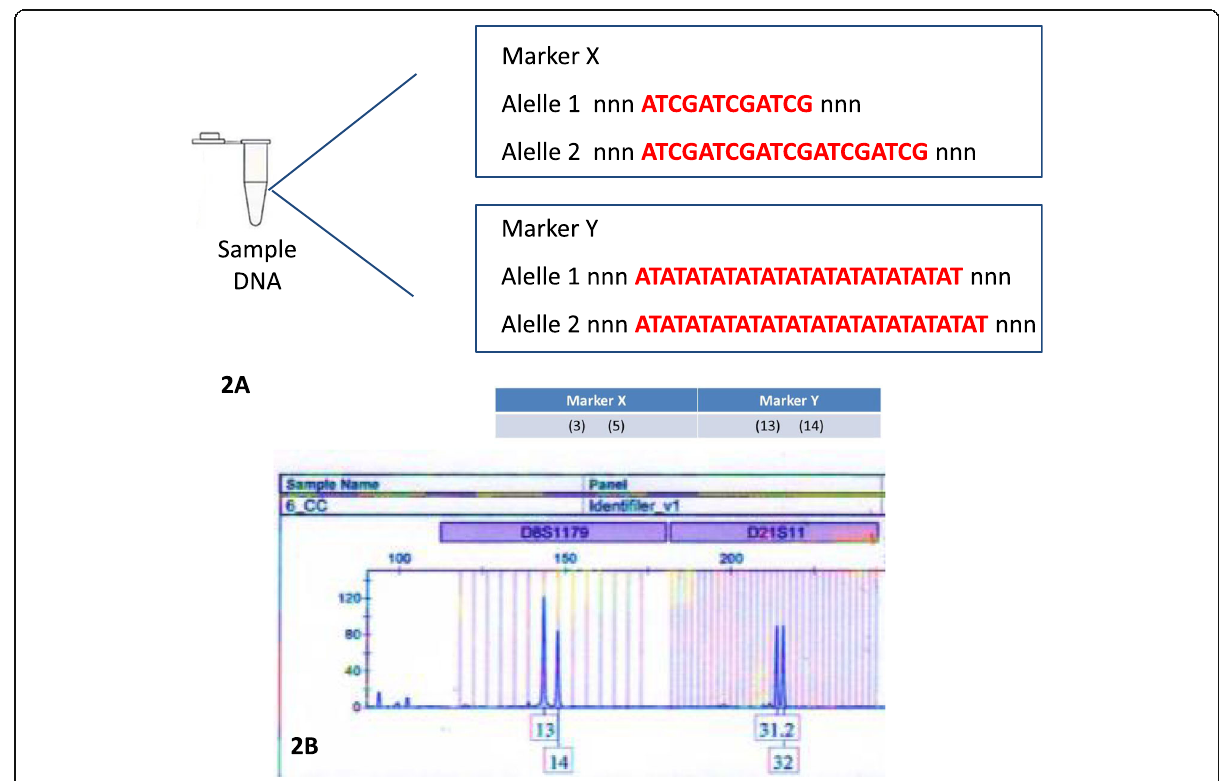
Fig. 2 a Illustrative scheme demonstrating the quantification of the repetitive regions - STR. STR analysis is performed initially by a PCR reaction that amplifies the region where the replications occur. Then the Sequencing is applied, which indicates the number of repetitions that the marker presents. The X-marker presents three and five replicates of each parent allele, while the other Y-marker presents the same number of replicates in the two alleles. b In the electropherogram, it is possible to see the peaks of two markers indicating the number of repetitions presented by a sample